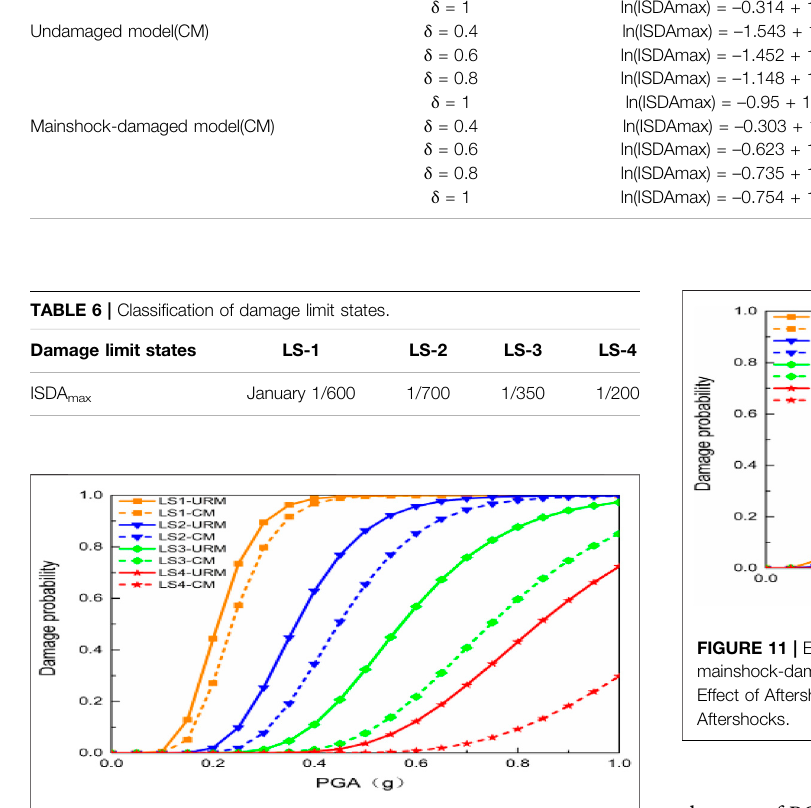
FIGURE 10 | Comparison of fragility curves of the URM and CM model subjected to mainshock only.